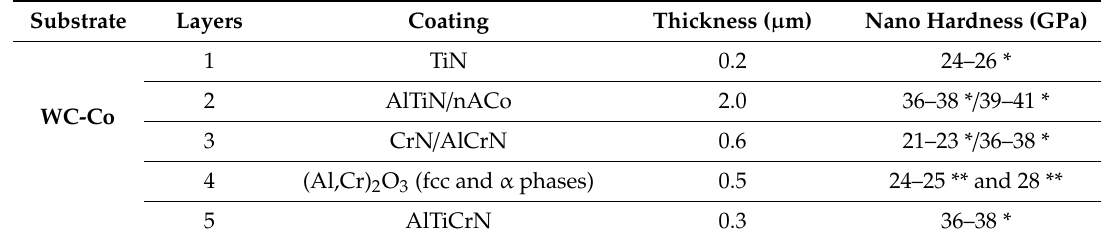
Table 1. Thickness and hardness of the coating layers deposited on WC-Co substrate. Substrate